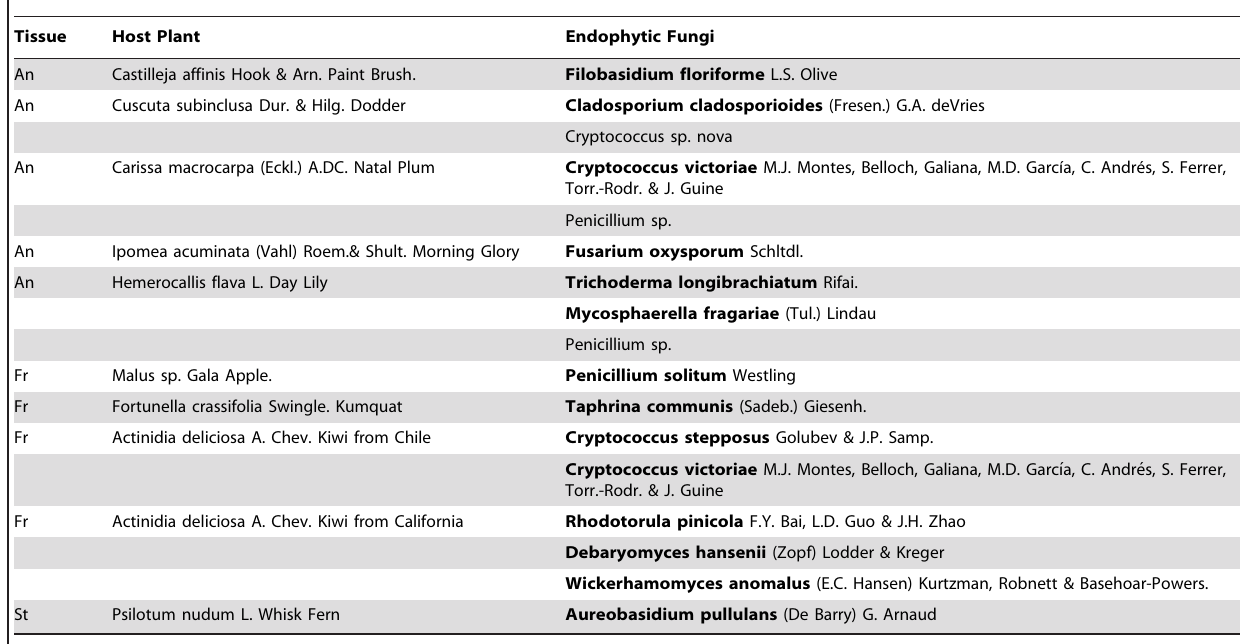
Table 1. Endophytic fungi isolated from plant anthers (An) fruit (Fr) and stems (St).